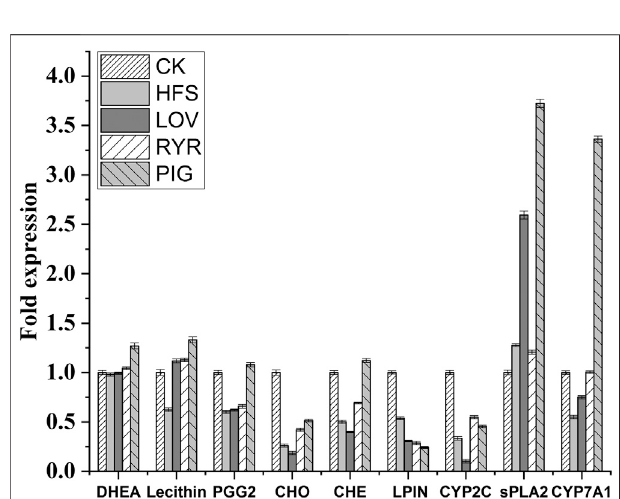
FIGURE 5 | Changes in metabolites and genes in metabolic pathways (The red circles indicate the metabolites with up-regulated abundance, the green circles indicate the metabolites with down-regulated abundance, the redboxesindicategeneswhoseexpressionlevelsareup-regulated,and